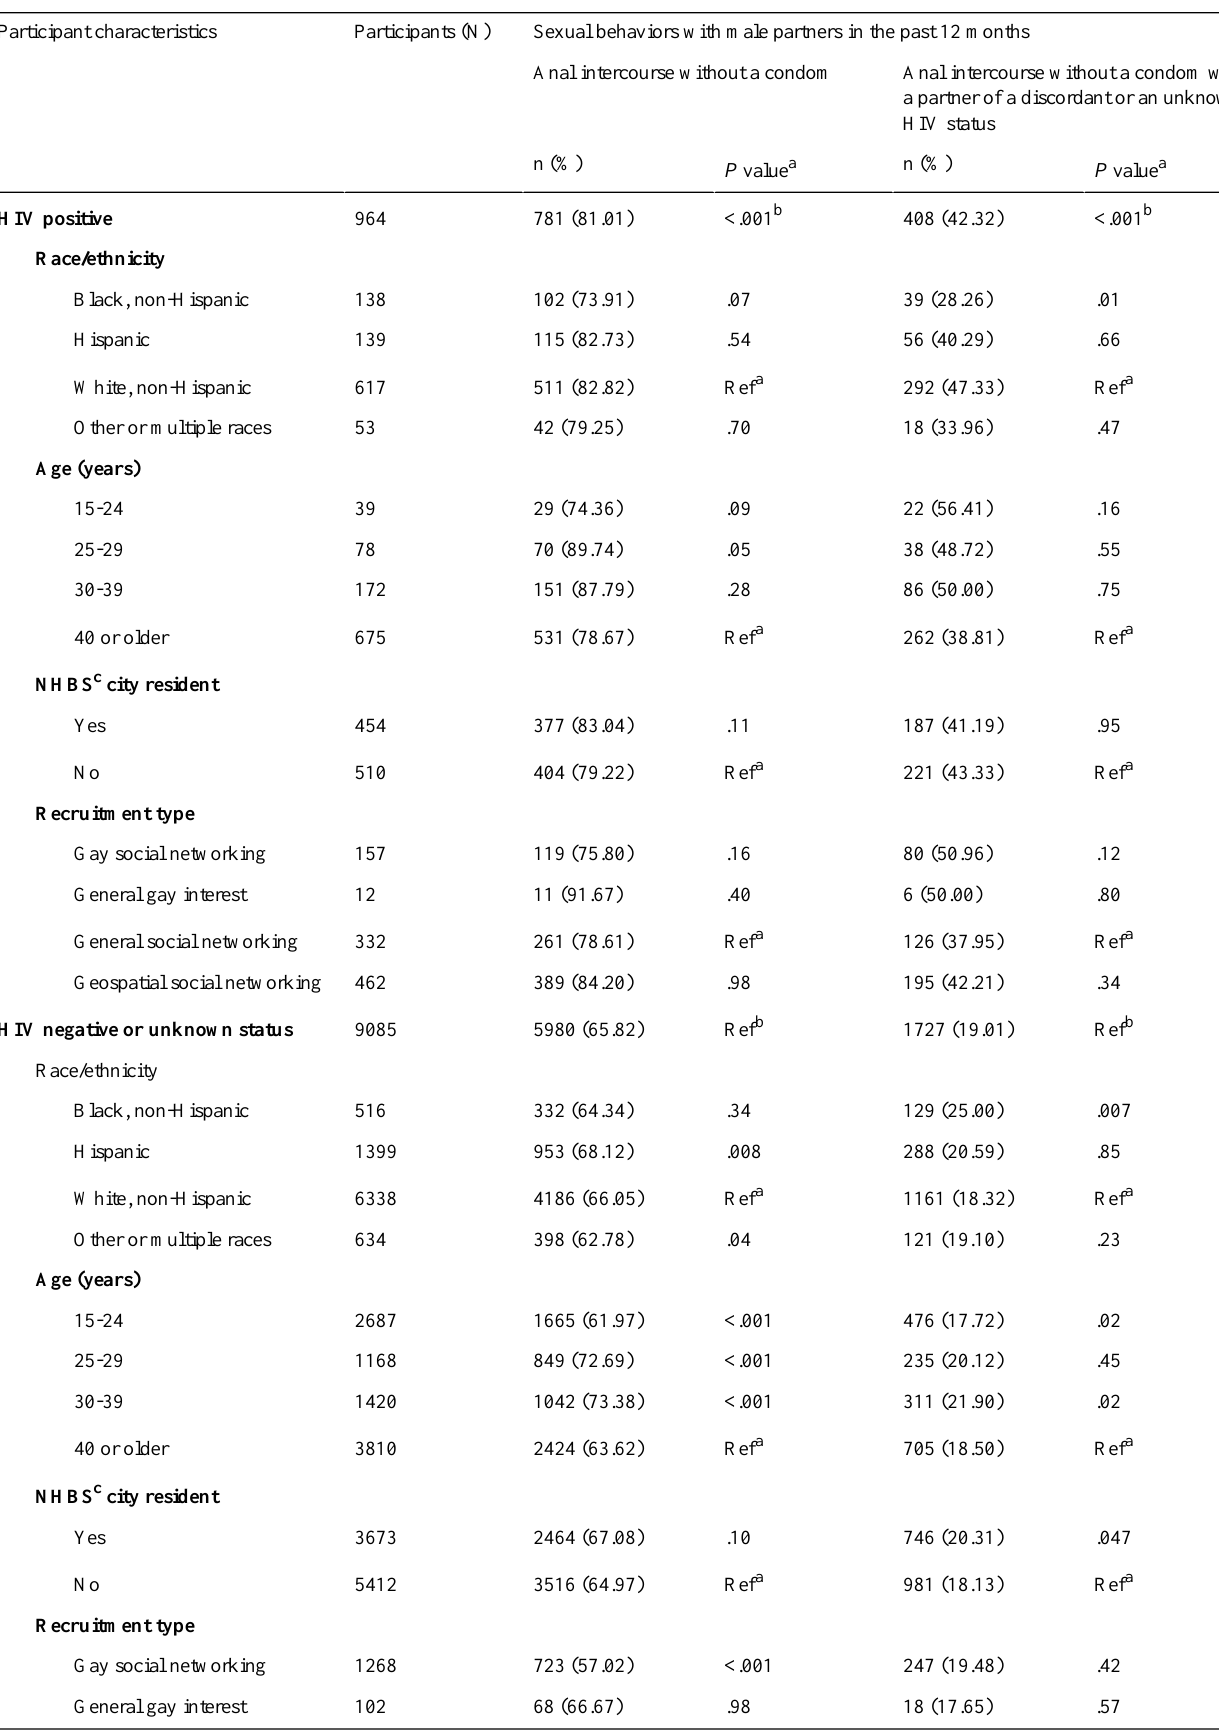
Table 3. Sexual behaviors with male partners of men who have sex with men in the American Men’s Internet Survey, United States,